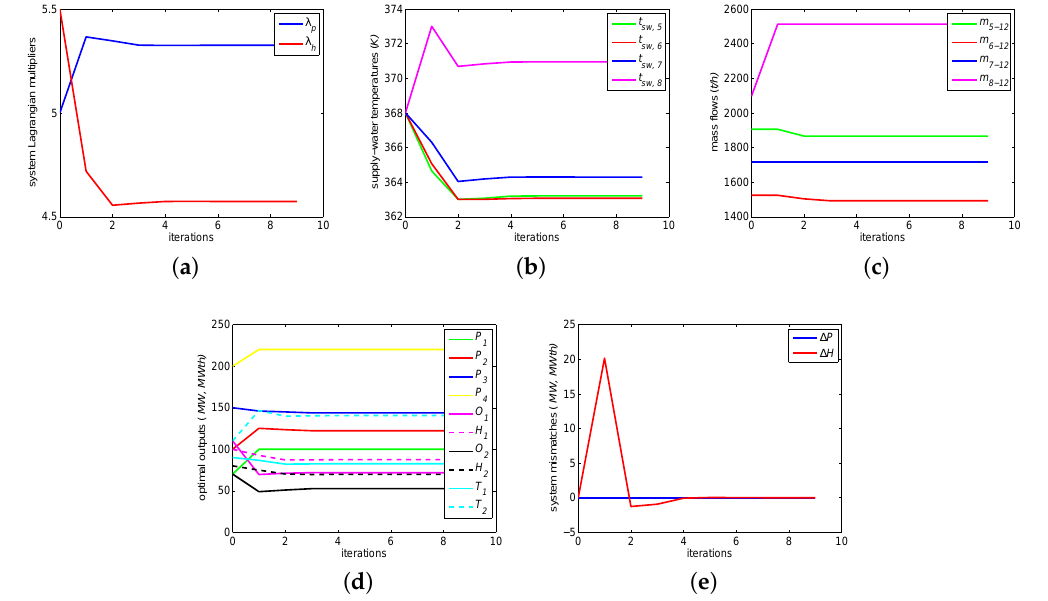
Figure 6. Case study 3: With network transmission constraints. ( a ) system Lagrangian multipliers; ( b ) supply-water temperatures; ( c ) mass flows; ( d ) optimal outputs; ( e ) system